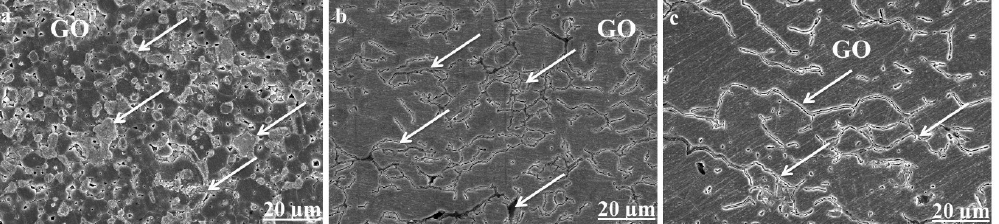
Figure 2. Cross-sectional SEM analysis of Cu-GO composites ( a ) Cu-GO(400), ( b ) Cu-GO(800), and ( c ) Cu-GO(1600).